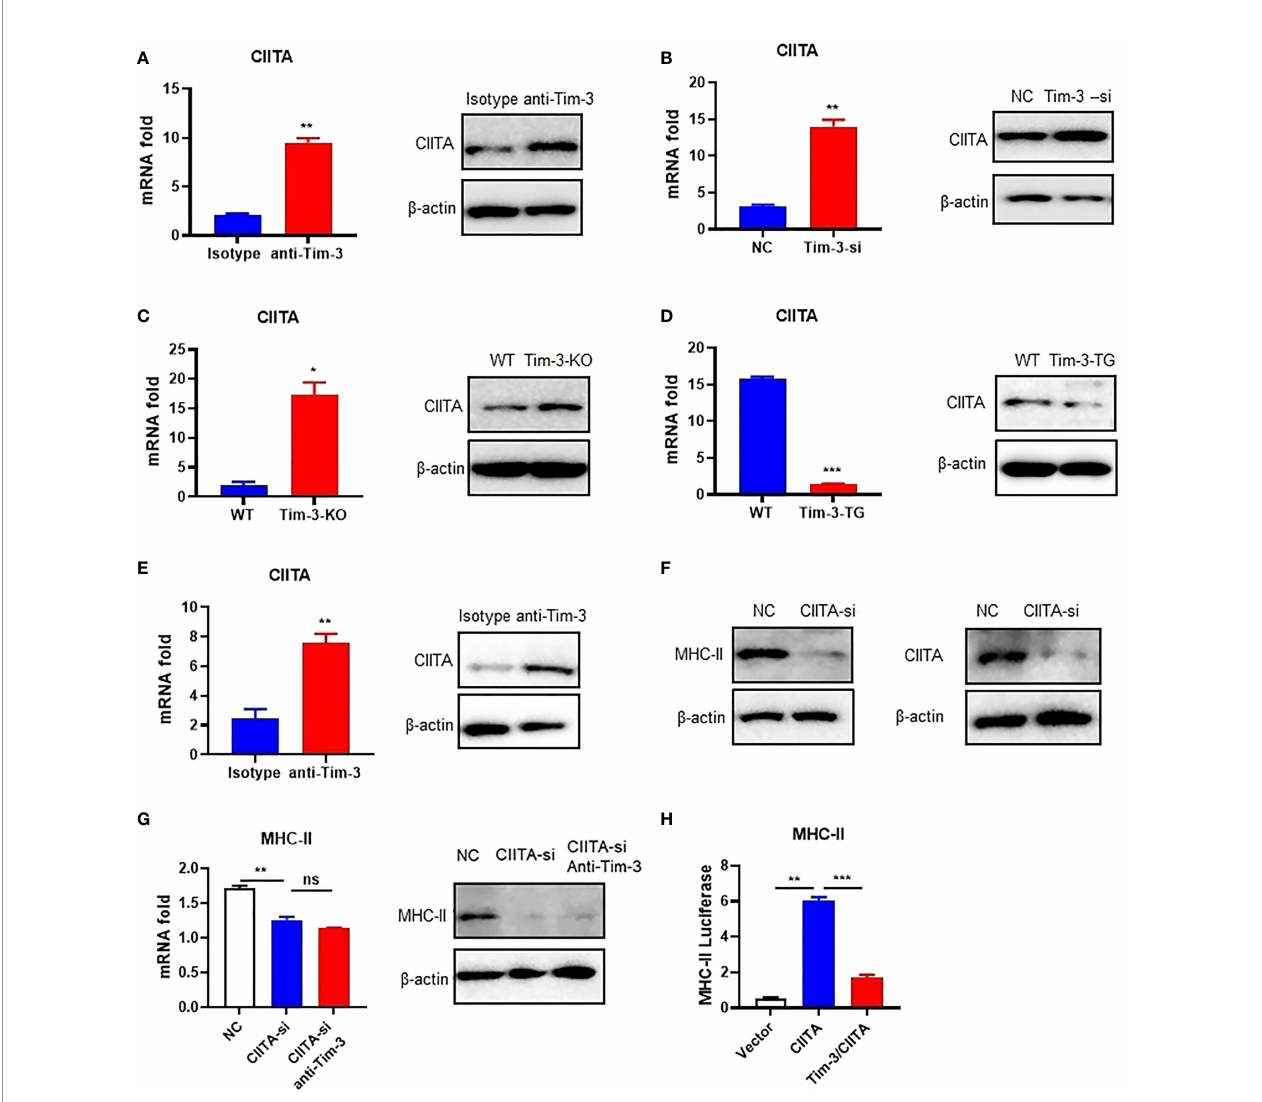
FIGURE 2 | Tim-3 signaling inhibits MHC-II expression through CIITA in macrophages. (A) The CIITA expression of RAW264.7 cells cocultured with anti-Tim-3 antibody (20 m g/ml) or isotype antibody for 24 h (left, mean ± SD, n = 3). (B) Tim-3-si RAW264.7 cells and RAW264.7 cells (left, mean ± SD, n = 3). (C) The peritoneal macrophages from Tim-3-KO and WT mice. The CIITA expression was detected by Western blot and RT-PCR (mean ± SD, n = 6). (D) The peritoneal macrophages from Tim-3-TG mice and WT mice (left, mean ± SD, n = 6). (E) WT mice were treated with anti-Tim-3 antibody or isotype antibody (10 mg/kg) by intraperitoneal injection at 0 and 24 h, and peritoneal macrophages were collected at 48 h to detect CIITA protein and gene levels (mean ± SD, n = 6). (F) siRNA- CIITA was transfection with RAW264.7 cells; CIITA and MHC-II expression was detected by Western blot at 48 h. (G) siRNA-CIITA was transfection with RAW264.7 cells cocultured with or without anti-Tim-3 antibody, and MHC-II expression was detected by RT-PCR (mean ± SD, n = 3) and Western blot at 48 h. (H) HEK-293T cells were transferred into pGL3-MHC-II reporter plasmid and CIITA plasmid, with or without Tim-3 plasmid for 48 h. Dual- fl uorescence was analyzed (mean ± SD, n = 3). (*p < 0.05; **p < 0.01; ***p < 0.001). ns, Not Signi fi